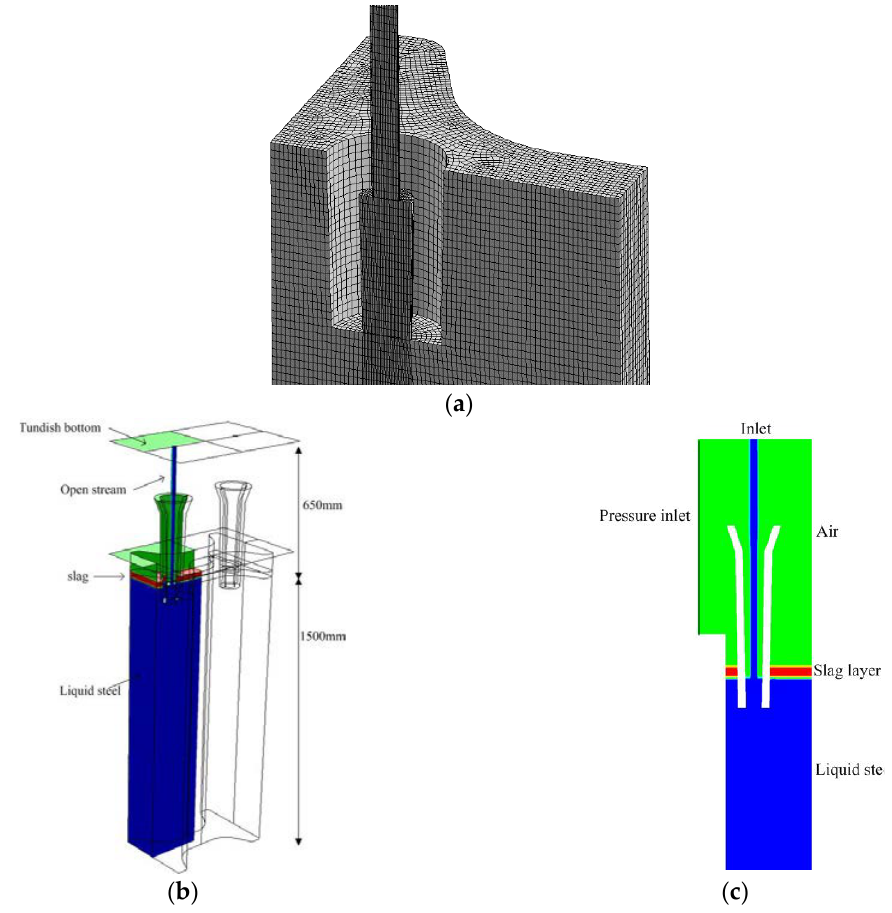
Figure 4. Grid ( a ); calculated domain schematic ( b ); and conditions of initial distribution for simulated phases ( c